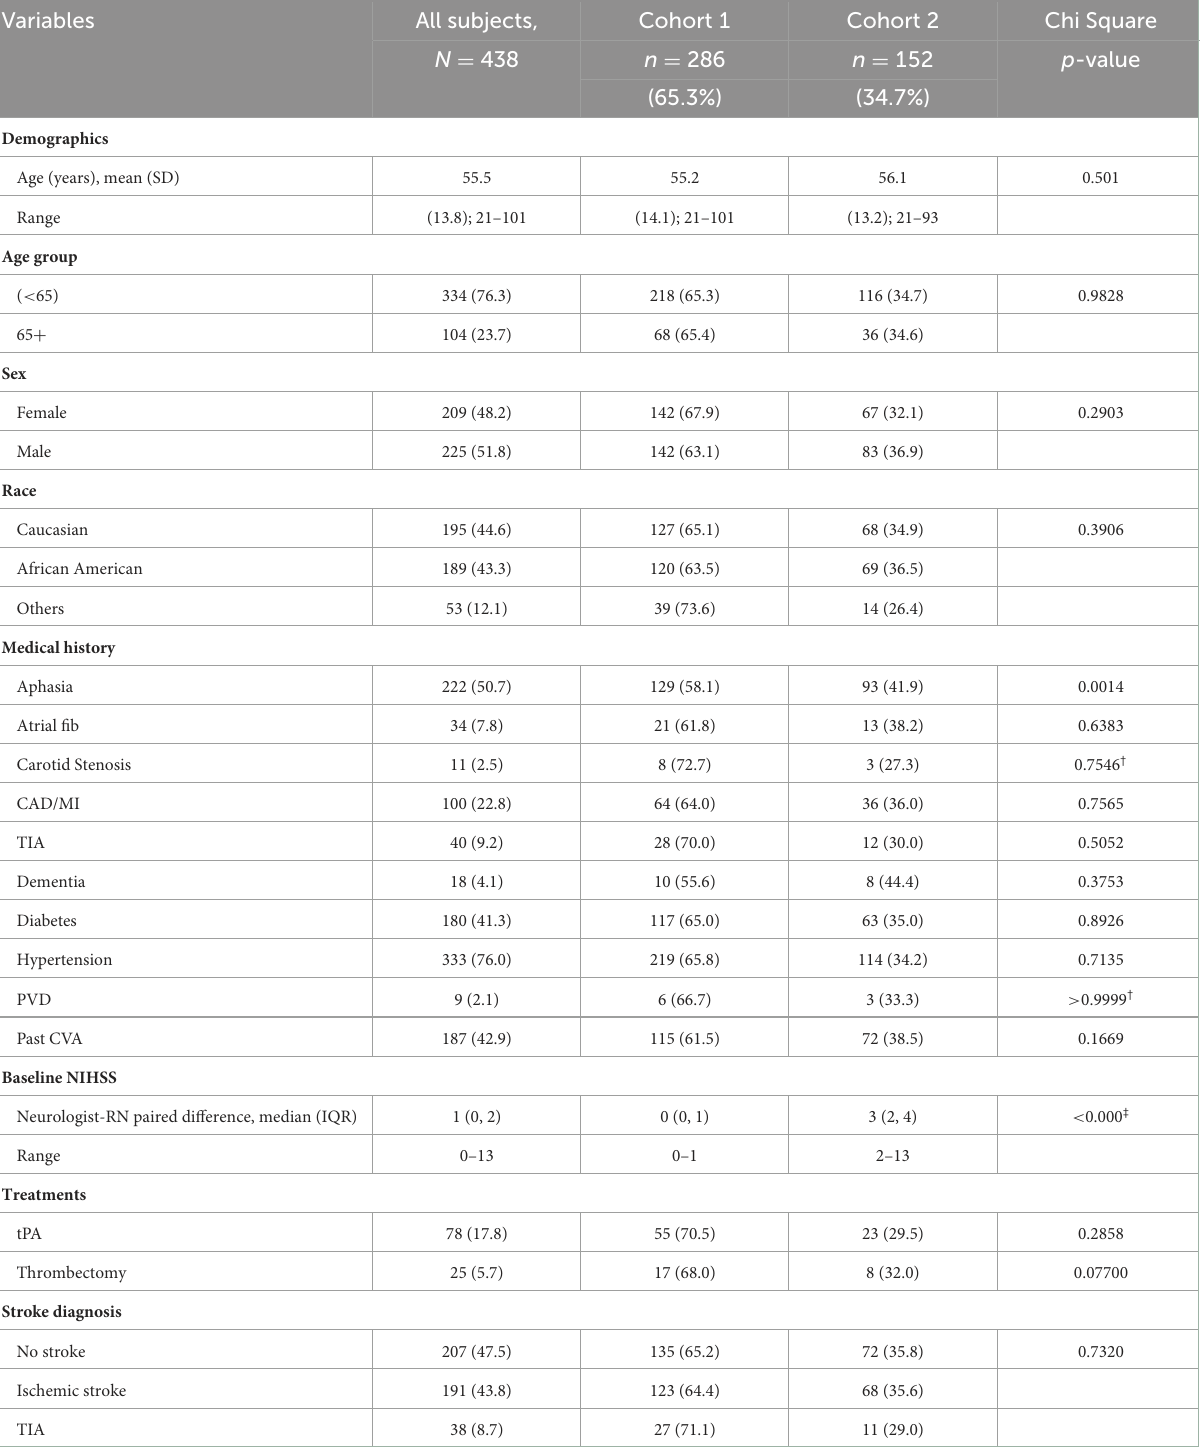
TABLE 1 Demographics and clinical characteristics of total group and